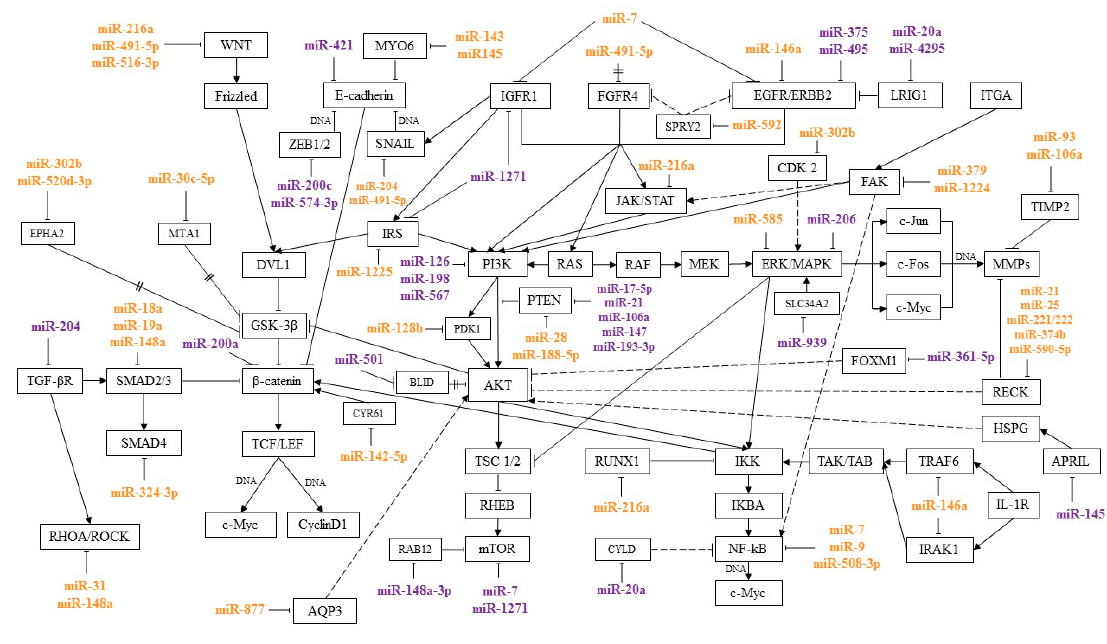
Figure 1. MicroRNAs and signaling pathways regulated by them in GC. miR —associated with metastasis; miR —associated with chemoresistance; activation; inhibition; interaction is assumed; mediated interaction. Activation of the Wnt/ β -catenin signaling pathway is found in 10% to 50% of cases and in many GC cell lines. Wnt/ β -catenin is one of the main signaling pathways involved in epithelial-